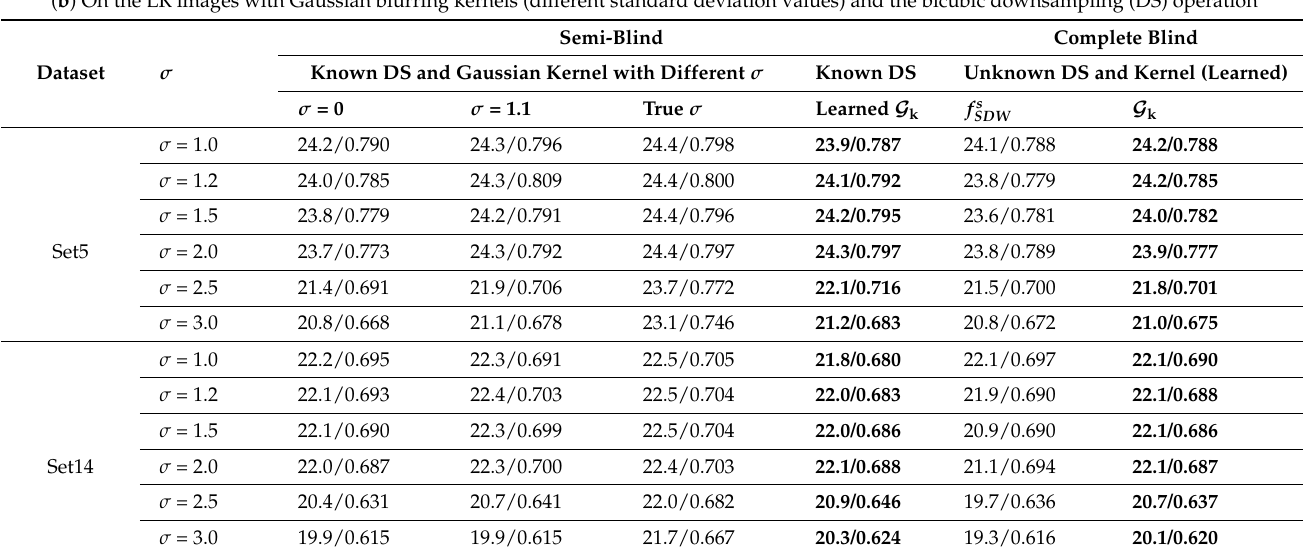
Table 1. Quantitative comparison with the varied kernels used in f s downsampled LR images; ( b ) on the LR images with Gaussian blurring kernels and the bicubic downsampling operation. The first numerical result represents the PSNR value, and the second denotes the SSIM